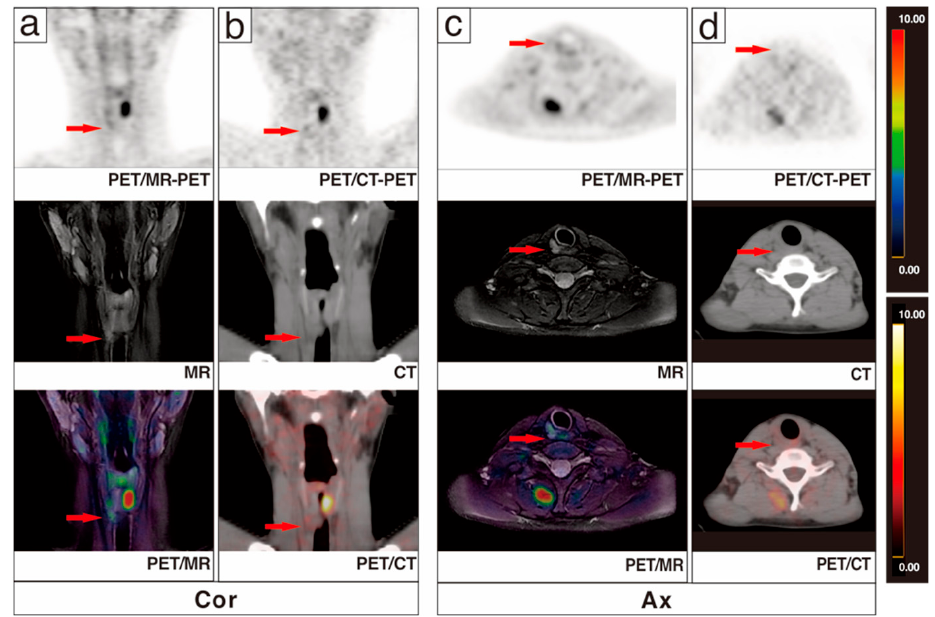
Figure 2. A 17-year-old post-operative DTC patient underwent 131 I treatment three times with persistently elevated Tg up to 371.0 ug/L. 131 I-WBS showed scattered iodine uptake foci in the right paratracheal area and lung lobes. 18 F-FDG PET/CT was performed for whole-body systemic evaluation. 18 F-FDG PET/CT showed no significant abnormalities in the thyroid region (( b , d ), red arrows); additional PET/MR of the neck showed a long T2 signal nodule in the right thyroid region with a mild metabolic increase SUVmax 1.7 (( a , c ), red arrows). In combination with medical history and 131 I examination, a residual/recurrent thyroid cancer was diagnosed. The patient was subsequently reoperated, and residual/recurrent thyroid cancer was confirmed by histological pathology.